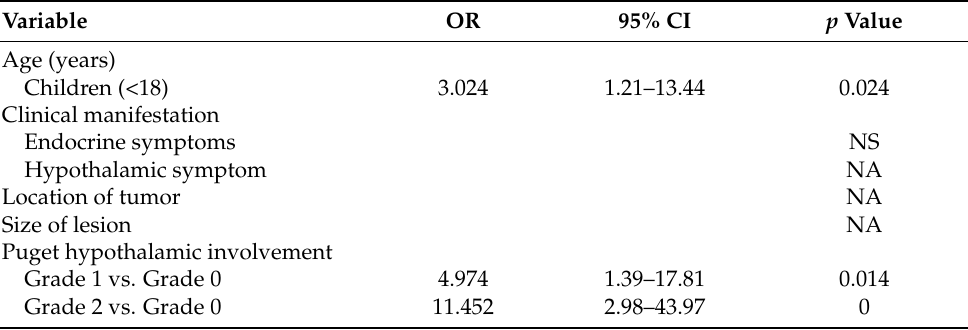
Table 3. Logistic regression analysis of factors related to preoperative hypopituitarism in cranio- pharyngioma